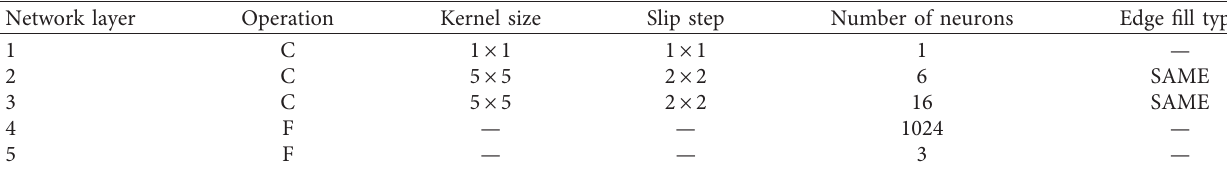
Table 2: Parameters of convolutional fully connected network